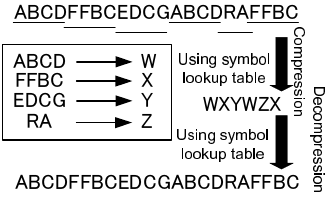
Figure 1. The conventional compression algorithm.